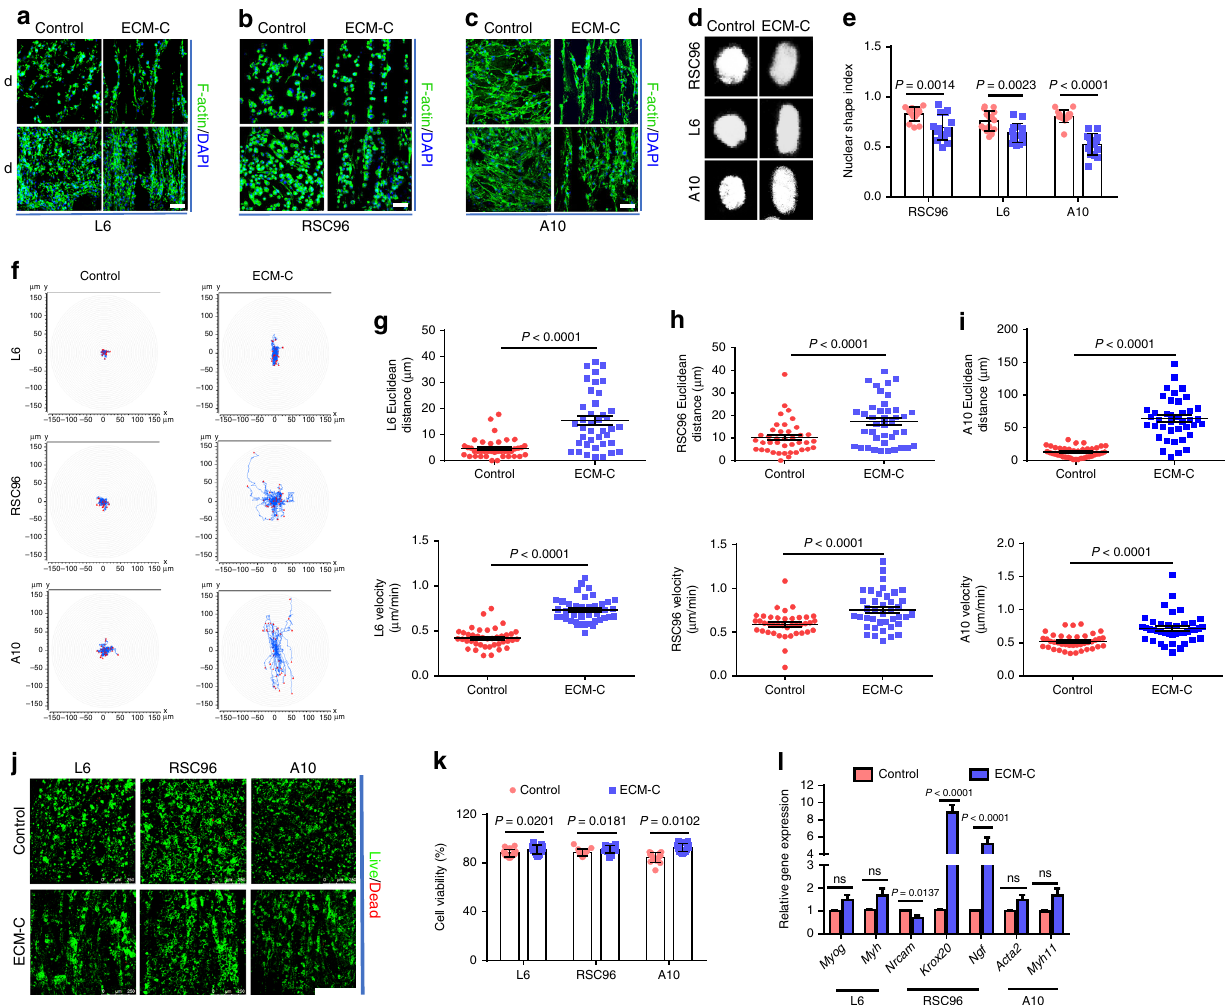
Fig. 3 Cellular guiding effects of ECM-C and control scaffolds. a – c Skeletal actin fi bres and nuclei of L6, RSC96 and A10 cells were respectively stained with fl uorescein isothiocyanate (FITC) conjugated phalloidin and DAPI at 1 and 3 days. d Typical images of L6, RSC96 and A10 cells nuclei stained by DAPI. e The nuclear shape index of L6, RSC96 and A10 cells on different scaffolds ( n = 15). f Migration traces of L6, RSC96 and A10 cells on different scaffolds. At least 40 cells were tracked for each group. g – i Euclidean distance and velocity of L6, RSC96 and A10 cells on different scaffolds ( n = 45). j , k Live/dead staining and cell viability of L6, RSC96 and A10 cells on different scaffolds at 7 days. Live cells stained green and dead cells stained red ( n = 15). l Real-time PCR analysis of Myog (myogenin) and Myh (myosin heavy chain), gene expression of L6 cells, Nrcam (neuronal cellular adhesion molecules), Krox20 (early growth response 2), Ngf (nerve growth factor) gene expressions of RSC96 cells, Acta2 ( α -smooth muscle actin) and Myh11 (smooth muscle myosin heavy chain) gene expression of A10 cells on different scaffolds after culture for 7 days ( n = 5). Images and data are representative of n = 3 individual experiments, and bar heights and error bars represent means ± s.e.m. ( t -test). Statistical analysis (ns = no signi fi cance). Scale bars: a – c , 50 μ m, j , 250 μ signi fi cantly higher in ECM-C than that in control scaffolds, by the blood (Fig. 5c). For control group, the defects were still whilst the number of iNOS-positive cells in ECM-C was close to visible even after one-month implantation and partially fi lled with that in control scaffolds (Fig. 4h). These data suggested that white fascia-like tissue (Fig. 5b). For the ECM-C-treated group, compared to the control scaffolds ECM-C had better immuno- the defects were almost completely fi lled with neotissue and the modulatory and biocompatible properties. grafted area became indistinguishable from the surrounding native muscle except the boundary location marked by black sutures (Fig. 5c). H&E staining of the cross-sections of healed areas showed that a large number of cells in fi ltrated the interior of the scaffolds along with the deposition of large amounts of new ECM (Fig. 5d). This was not seen with control scaffolds, in which cell in fi ltration and new ECM formation were very limited (Fig. 5d). This was further con fi rmed by Masson trichrome staining, showing the remainder of high-density collagen located on the defect surface (Fig. 5d). Conversely, only a small fraction of collagen fi bres scattered throughout the defect treated with ECM-C (Fig. 5d). As quanti fi ed, the collagenous area of control